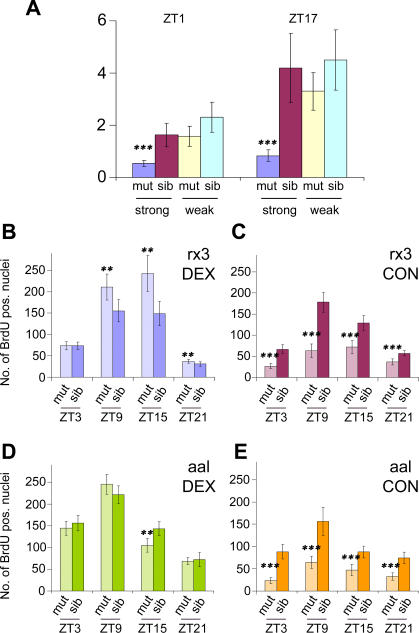
Activation of Glucocorticoid Signaling Rescues Circadian Cell Cycle Defects(A) Cortisol levels in weak and strong rx3 mutants. Luminescence immunoassay (LIA) of cortisol at two time points for strong allele mutants (blue), strong allele siblings (red), weak allele mutants (orange), and weak allele siblings (green) on 6 dpf. Error bars indicate the 95% confidence interval. Data represent pooled results from three independent experiments. Asterisks indicate statistically significant differences between strong allele mutants and all other larvae as determined by the Mann-Whitney test: ***, p < 0.001.(B and C) Effects of dexamethasone treatment on BrdU incorporation in strong rx3 mutants and wild-type siblings. Larvae were raised from 2 dpf to 6 dpf in the presence (B) or absence (C) of 25 μM dexamethasone (DEX). Means of BrdU-positive nuclei at four circadian time points on 6 dpf are shown for DEX-treated mutants (“mut,” light blue) and wild-type siblings (“sib,” blue) (B), and for untreated (CON) mutants (light red) and wild-type siblings (red) (C). Error bars show the 95% confidence interval of the mean. Asterisks indicate statistical significance of the difference between mutant and wildtype as determined by the Mann-Whitney test: **, p < 0.01; ***, p < 0.001. Pooled results of four independent experiments are shown.(D and E) Effects of dexamethasone treatment on BrdU incorporation in aal mutants and wild-type siblings analogous to (A) and (B). Means of BrdU-positive nuclei are shown for DEX-treated mutants (light green) and wild-type siblings (green) (D) and for untreated mutants (light orange) and wild-type siblings (orange) (E). Pooled results from two independent experiments are shown.